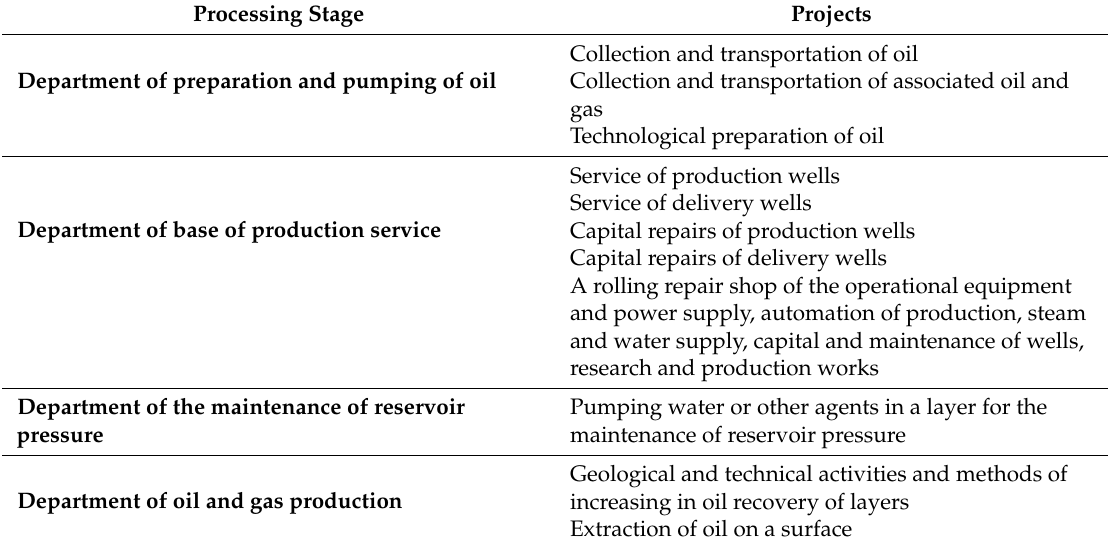
Table 2. Descriptions of different stages of oil and gas production.